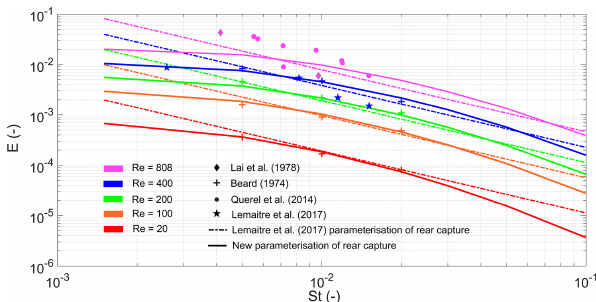
Figure 1. A new parameterisation of the collection efficiency due to rear capture in the raindrop wake. Also plotted are the data used to fit the parameterisation and the original model of Lemaitre et al.